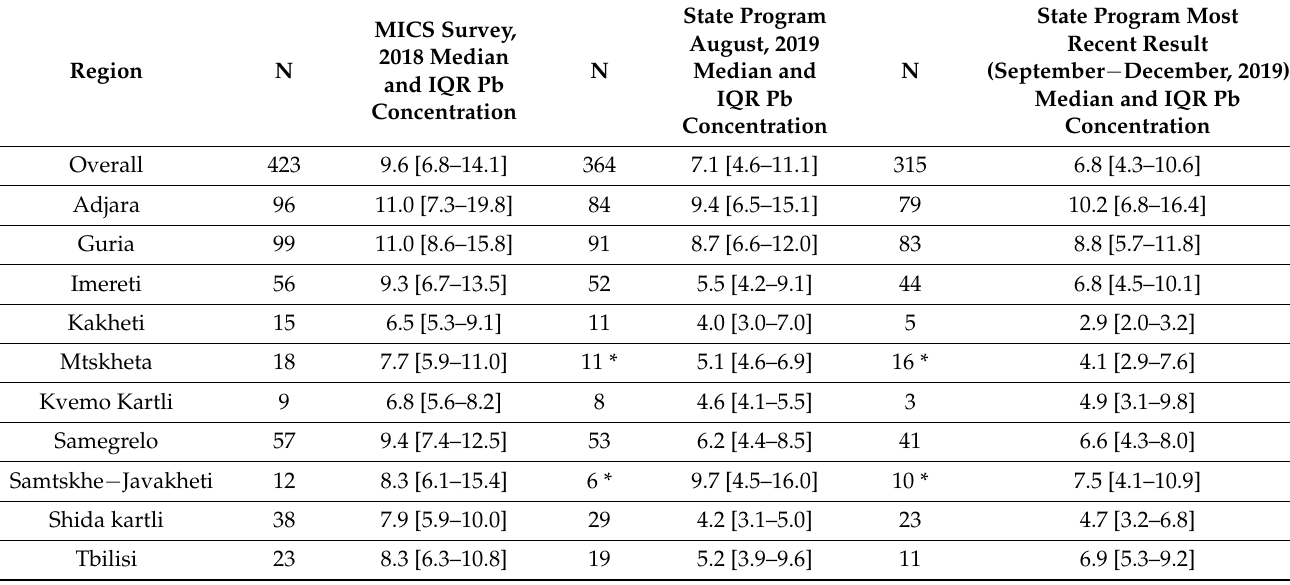
Table 2. Summary of the median changes in Pb concentration ( µ g/dL) between MICS Survey (2018) and state program (2019).